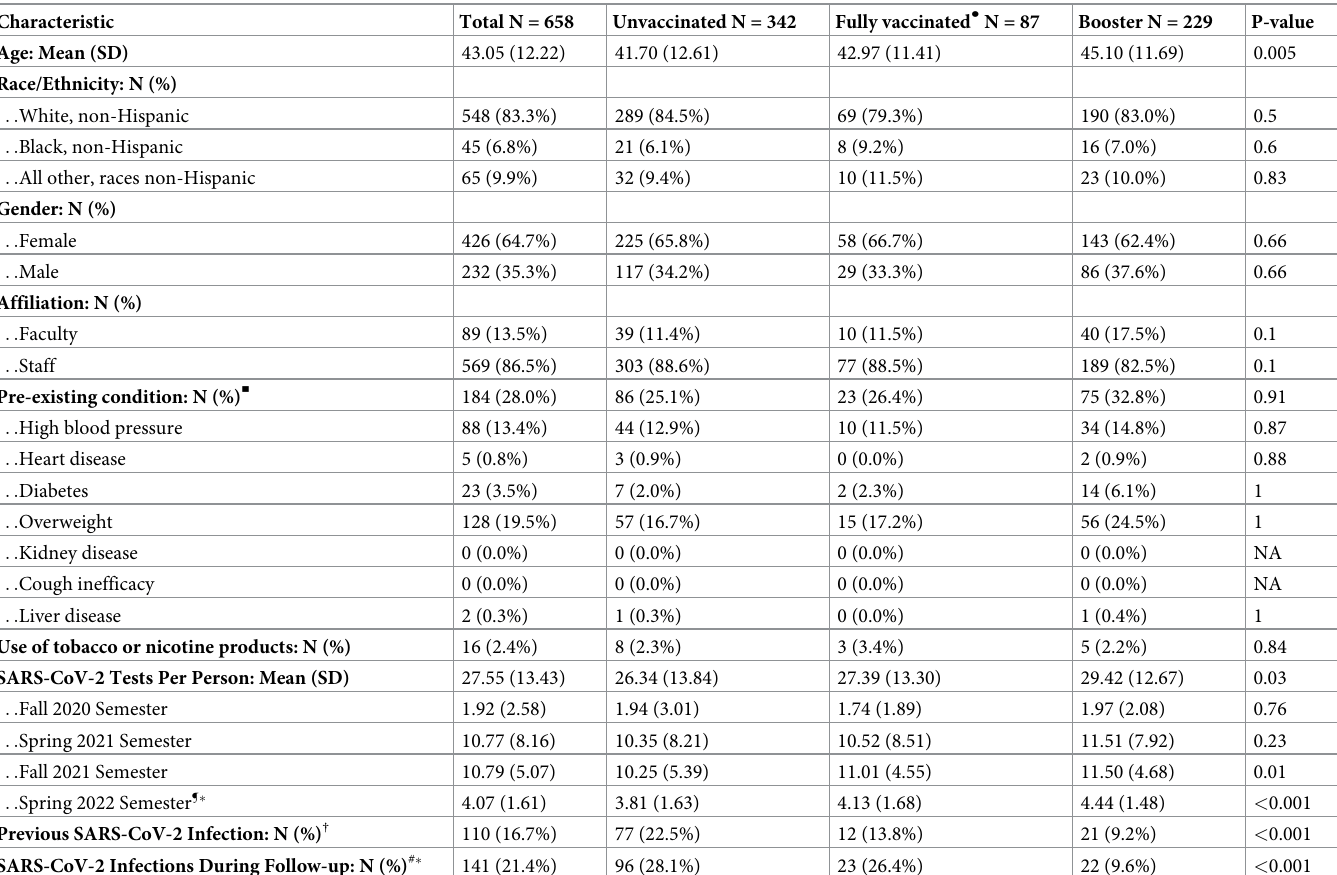
Table 2. Descriptive characteristics for employees in the analytic sample after propensity score